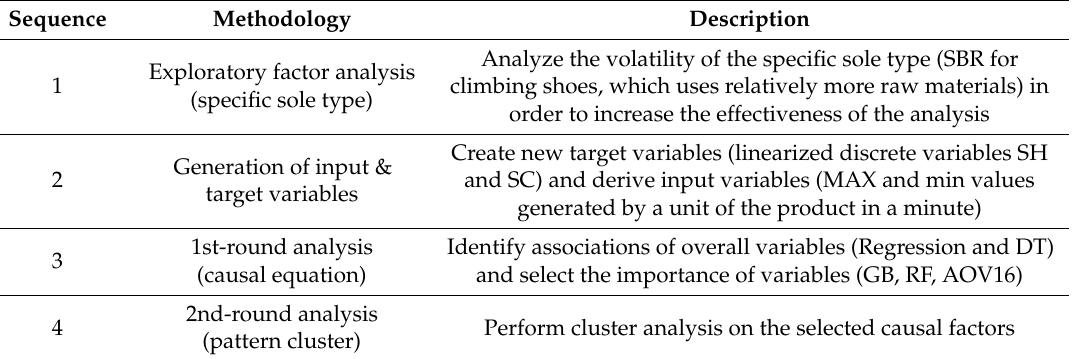
Table 4. Analysis methodology of vulcanization